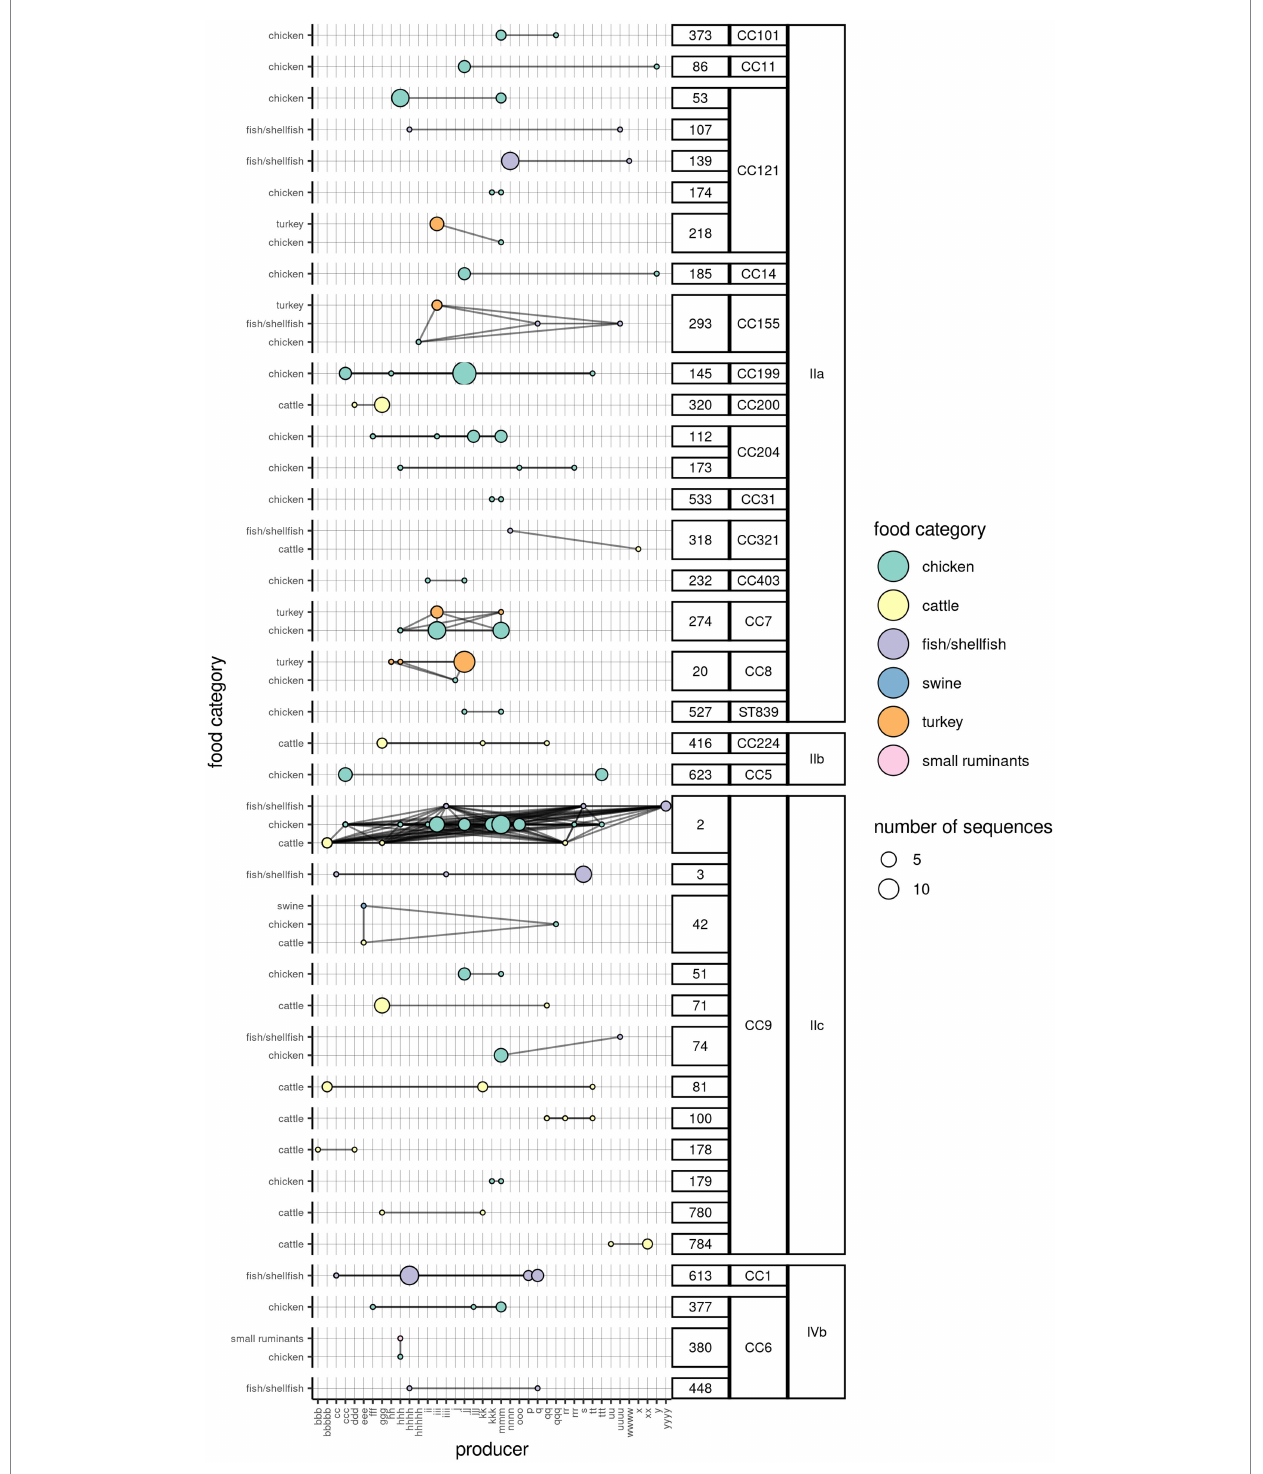
FIGURE 3 Network of Lm clusters among the food product categories and the corresponding producers. One circle indicates the presence of a particular cluster in a food category ( y -axis), originating from a producer ( x -axis). The color of the circle is indicative of the food category, while its size indicates the number of WG sequences. The horizontal lines connecting any two circles indicate that the cluster is present in the same food product category across multiple producers. The vertical lines connecting any two circles indicate that the cluster is present in more than one food product categories from the same producer. The oblique lines indicate the presence of the same cluster in different food categories from different producers. The clusters are aggregated by their membership to the CC and serogroup (labels on the